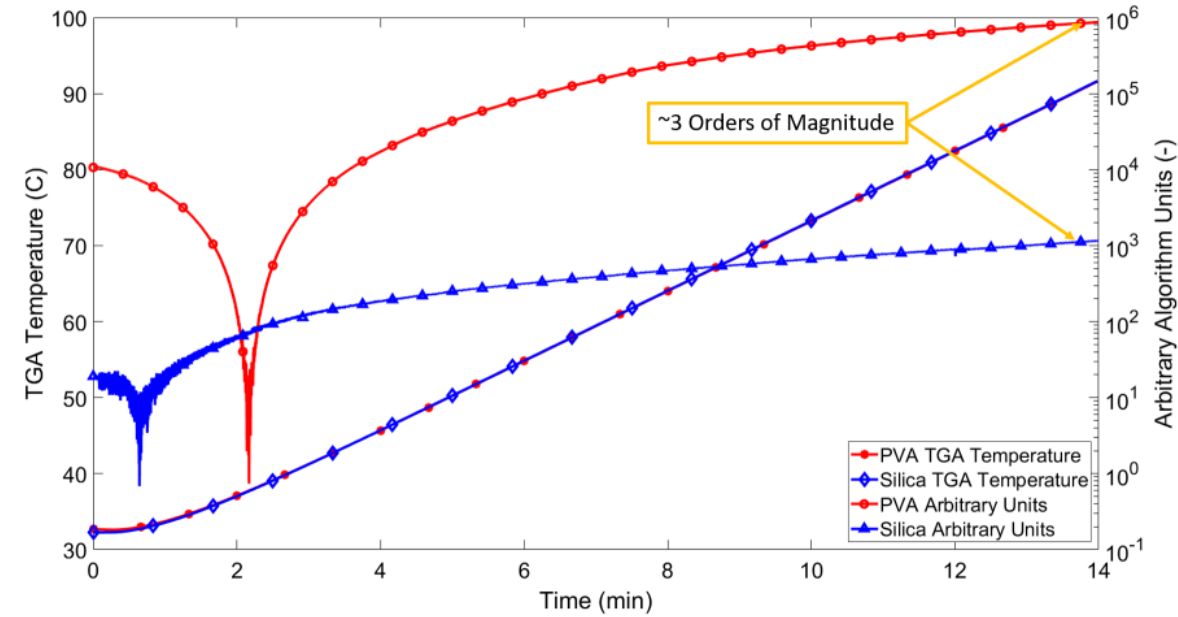
Figure 15. Overlay of TGA measurements and sensor